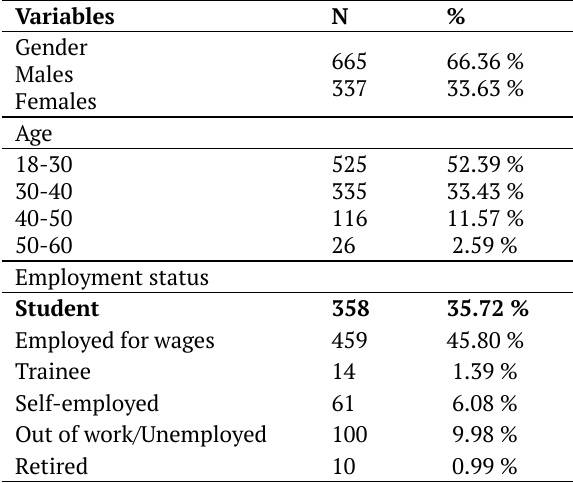
Table 1. Demographic characteristics of the